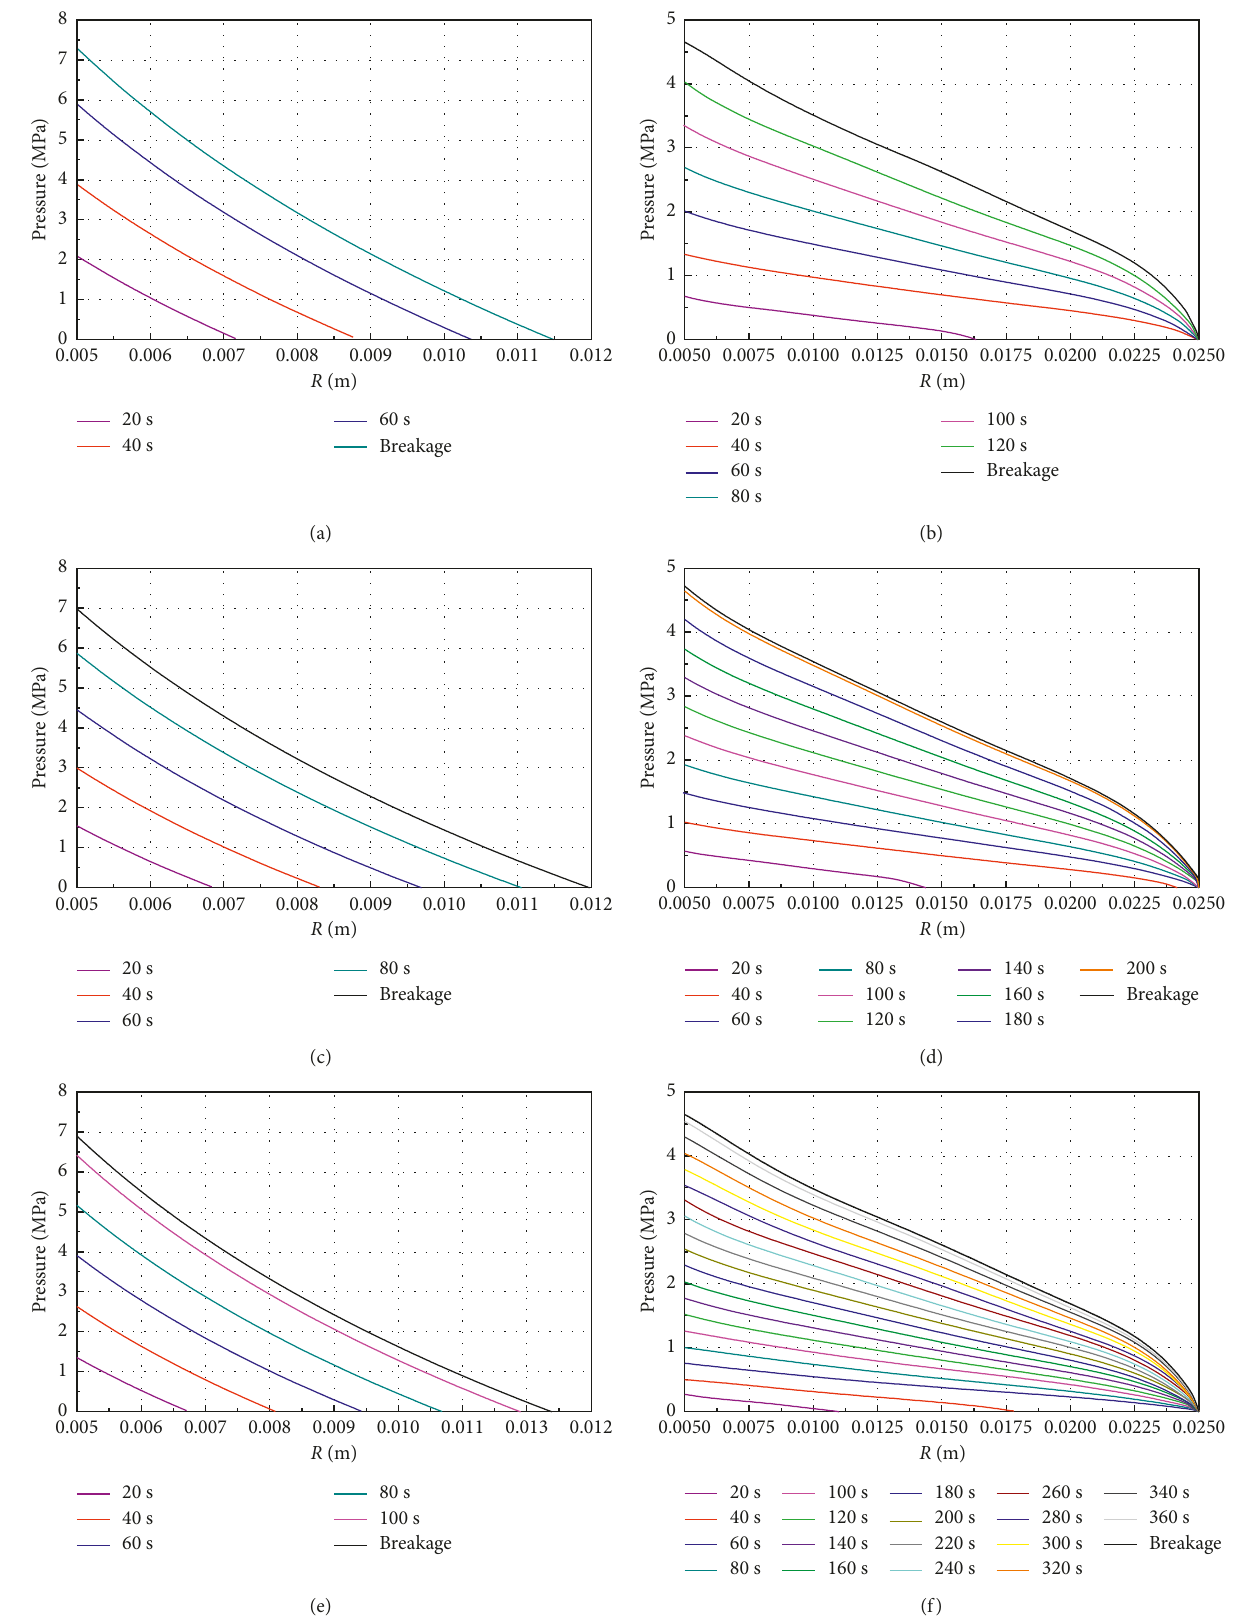
Figure 14: Plots of pore pressure distribution during fracturing (I). (a) W1, (b) G1, (c) W2, (d) G2, (e) W3, and (f)